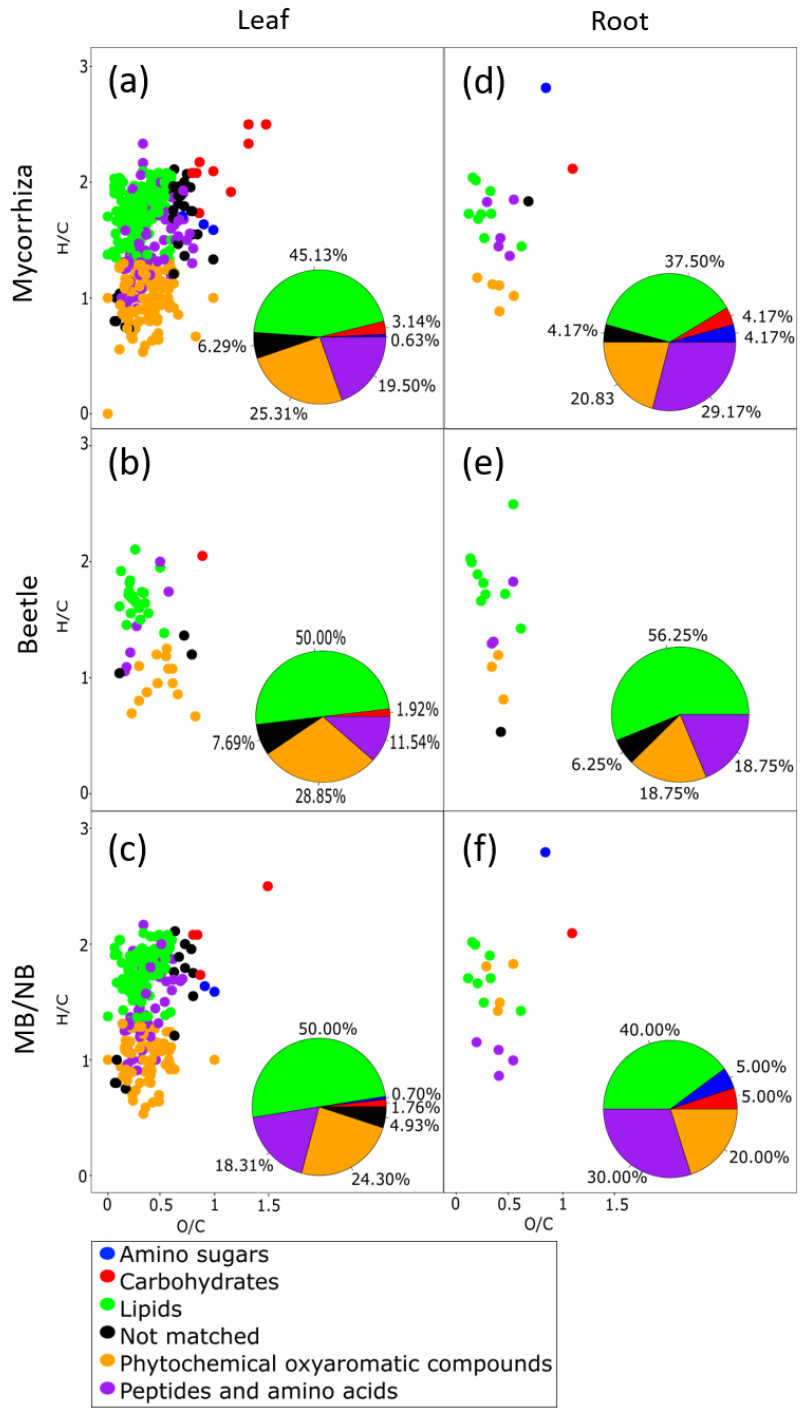
Figure 4. Van Krevelen plot combined with multidimensional stoichiometric compound classification (MSCC) classifies all mass features in leaves ( a , b , c ) and roots ( d , e , f ) of mycorrhized ( a , d ), beetle infested ( b , e ) and mycorrhized and beetle-infested ( c , f ) trees. The proportions of the classified mass features in each chemical group are given in the pie charts. All mass features were discriminant for treatment separations in orthogonal partial least square regression discriminant analyses (OPLS-DA) (VIP > 1.0; CV-ANOVA < 0.05; individual mass feature p -values < 0.05; log2 ratio of < − 1.0 or >1.0). Values are relative abundances, logarithmically transformed and Pareto scaled with